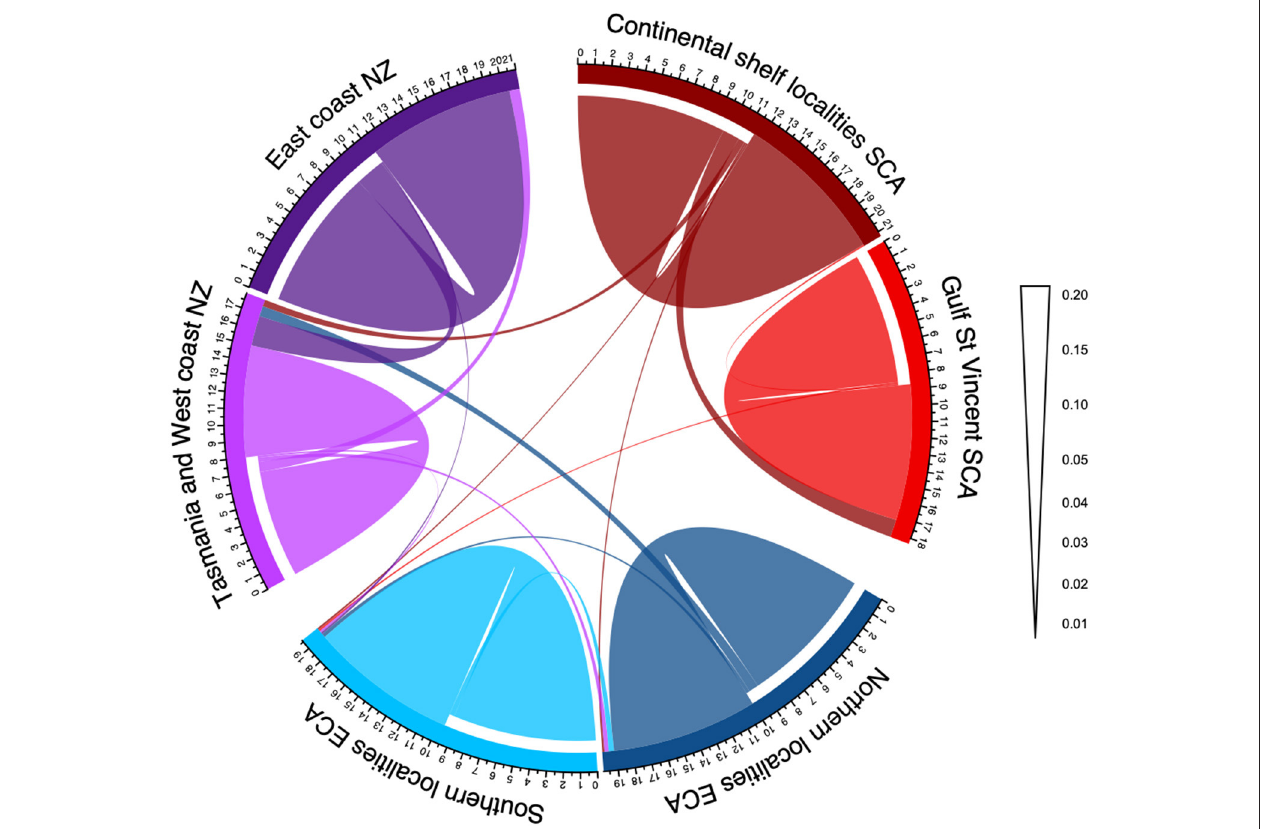
FIGURE 5 | Circos plot of inferred contemporary migration rates (per last generations) between local populations of Australasian common dolphins ( Delphinus delphis ) based on 14,799 SNPs. Plot corresponds to the migration directionally (full values from BayesAss are provided in Supplementary Table 2 ). Width of the curves indicates the amount of migration according to the scale going from one subpopulation into another one. Scale bar is in units of the proportion of migrations. Ticks represent the gross number of migrants per 100s. Migration rate < 0.01 is not shown. SCA, * Southern coast of Australia; ECA, Eastern coast of Australia; NZ, New